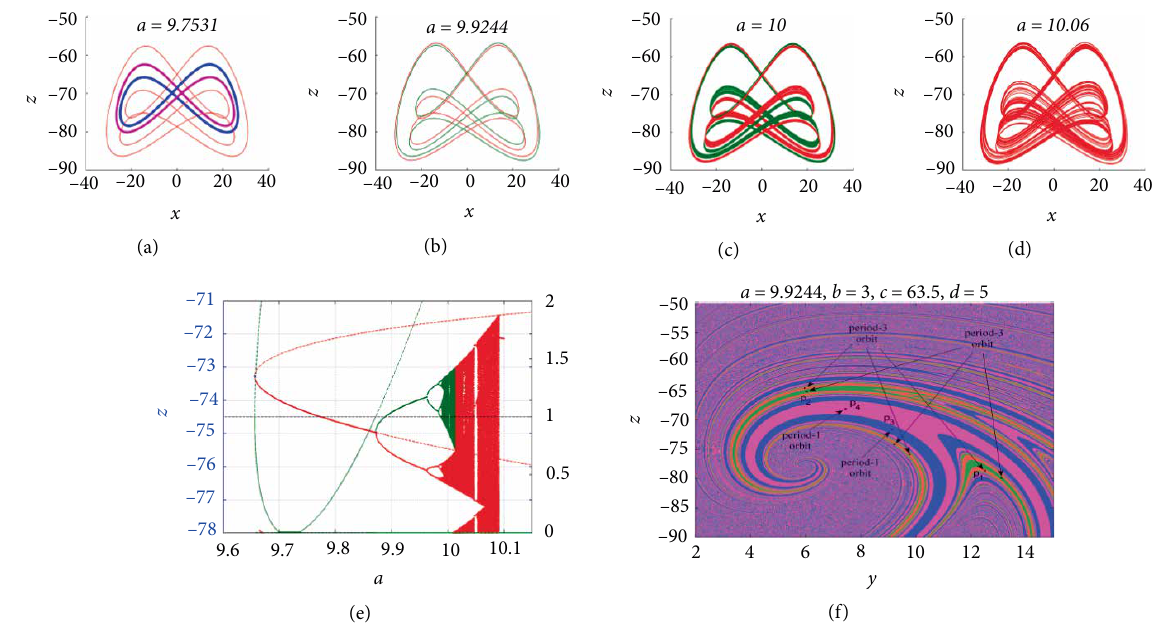
Figure 5: The period-3 limit cycle, its bifurcations and basin of .7531 , where the initial values are (0, 7.7231, −68.5635) 푎 = 9 and (0, ±12.5342, −78.6258), respectively. Like Figure 4(e),